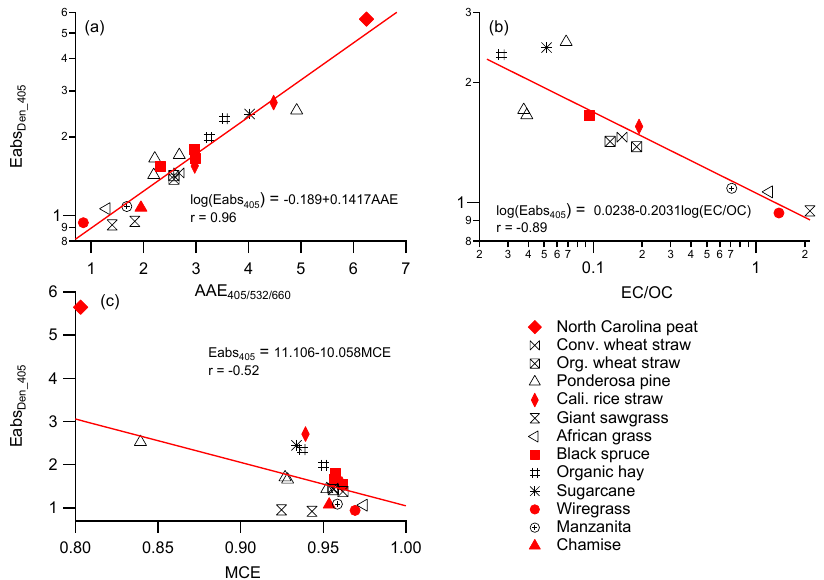
Figure 5. 405nm absorption enhancement parameterized with (a) AAE, (b) EC / OC, and (c) MCE. The symbols are sorted by fuel type and listed in the legend. Red lines are least-square fits of the data with the equation and correlation coefficient ( r ) reported for each case. Given the near absence of BC, peat burns are considered as outliers and not included in model